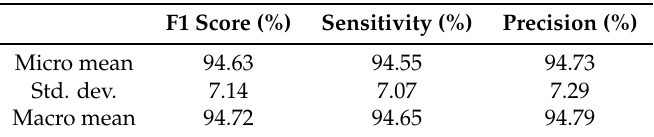
Table 3. Mean values for all test subjects after excluding test subject